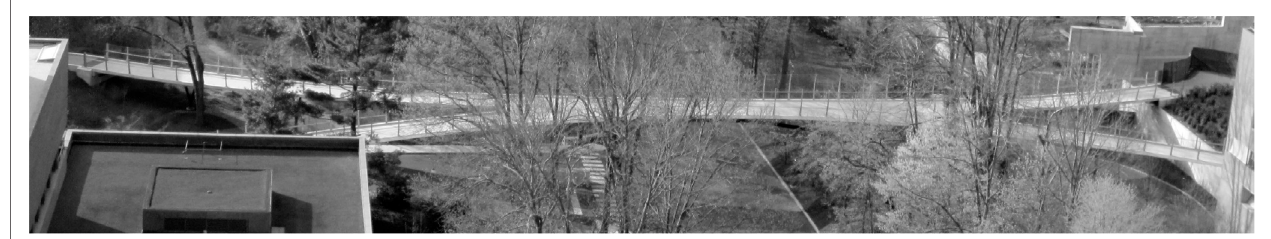
FIGURe 6 | top view of streicker Bridge .